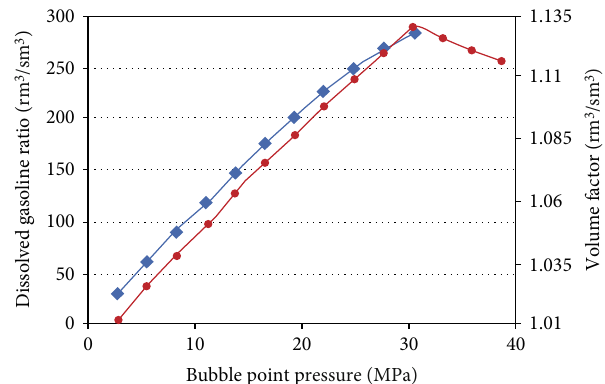
Figure 9: Dissolved gas-oil ratio and volume factor changing with bubble pressure.